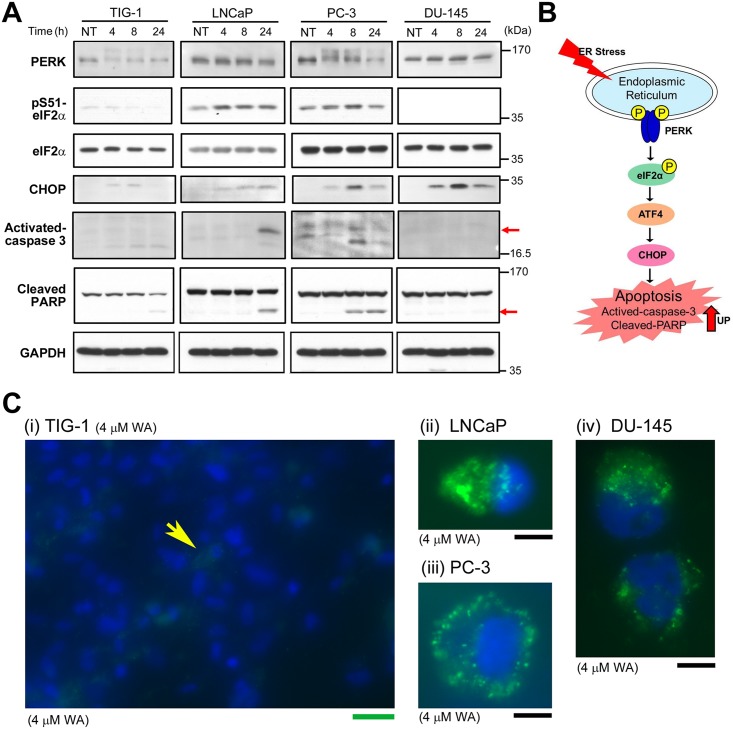
Expression profiles of ER stress–related proteins following WA treatment.(A) Western blot analysis to detect IRE-1α, PERK, pS51-eIF2α, CHOP, caspase 3, PARP, BiP, and GAPDH (loading control) in TIG-1, LNCaP, DU-145, and PC-3 cells at 4, 8, and 24 h after 4 μM WA treatment. NT: non-treated. (B) Schematic representation of the analyzed proteins in the apoptotic pathway induced by ER stress. (C) Typical fluorescence images of TIG-1 (i), LNCaP (ii), PC-3 (iii), and DU-145 (iv) that were treated with 4 μM WA for 24 h and subsequently treated with ROS detection reagents using the Image-iT LIVE Green ROS Detection Kit. Merged images are shown of cytoplasmic ROS signals (green) and nuclear DNA signals stained with Hoechst33342 (blue). Green bar, 100 μm. Black bar, 10 μm.